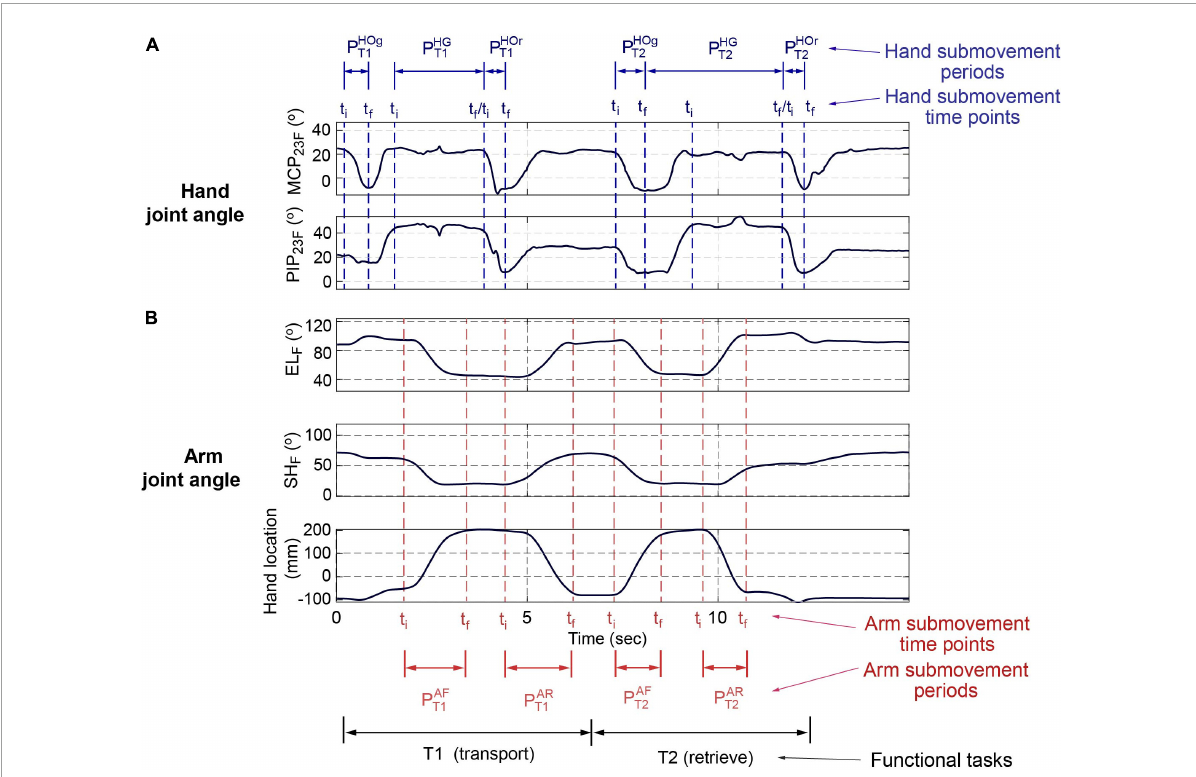
FIGURE2 Time points of the UE functional movements (object transport/retrieve; control subject 2; L 3 ; trial 2). Here, finger MCP and PIP flexion (MCP 23F , PIP 23F ) (A) , shoulder flexion (SH F ), elbow flexion (EL F ), and hand location (in movement direction) (B) are shown (MCP, metacarpophalangeal; PIP, proximal interphalangeal). The movement periods for hand movement and arm movement periods are listed in Table 1